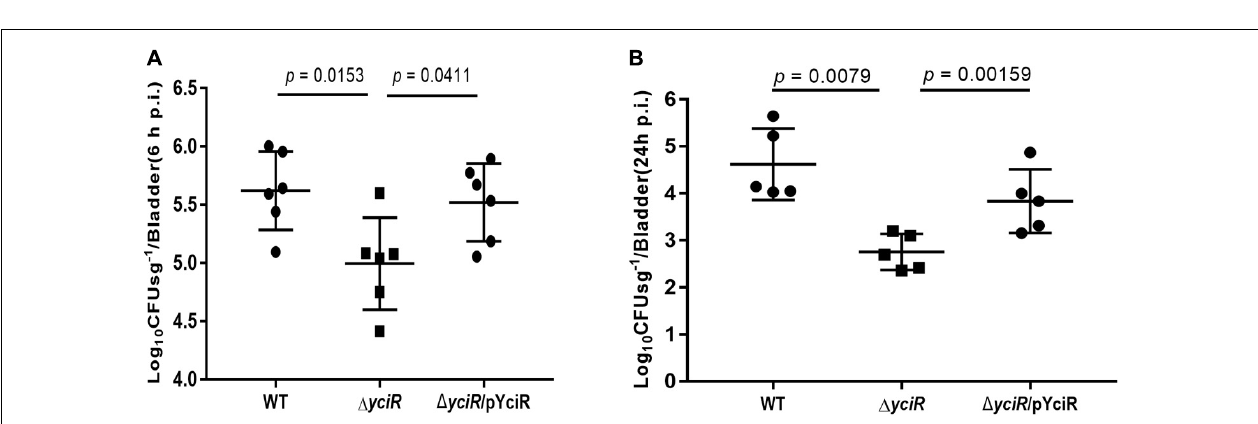
FIGURE 3 | yciR promotes E. coli CFT073 colonization in the bladders of Balb/c mice in acute infections. (A) Determination of the transurethral colonization ability of WT, (cid:49) yciR , and (cid:49) yciR pYciR strains in the bladders of Balb/c mice at 6 hpi. (B) Determination of transurethral colonization ability of WT, (cid:49) yciR , and (cid:49) yciR pYciR strains in the bladders of Balb/c mice at 24 hpi. The homogenates from the infected bladders of Balb/c mice with WT and yciR mutant strains were plated on the agar for CFU counts. The bars in the graph represent the mean ± SD . Each dot represents the bladder of one mouse. Three independent experiments were performed, and p -values were calculated using a two-tailed Mann–Whitney non-parametric